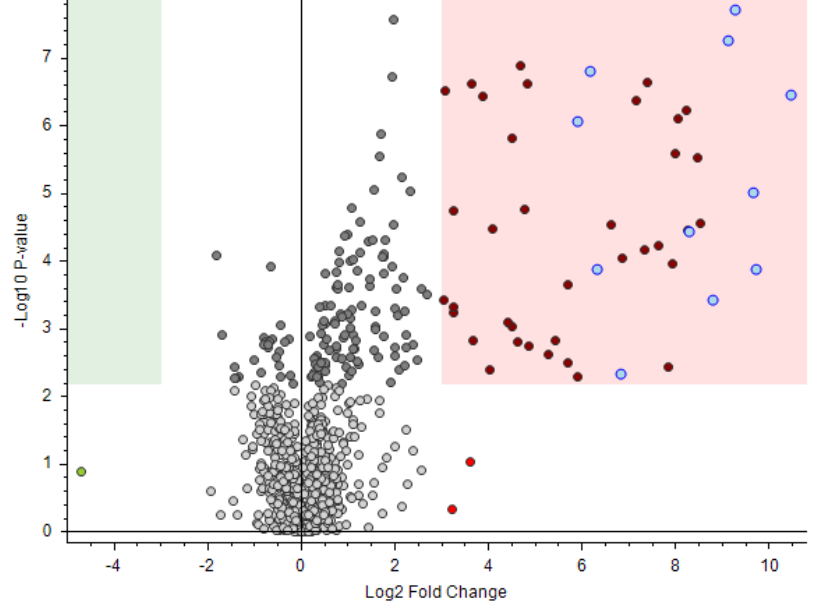
Figure 4. Differential analysis in order to reveal the spiked compound (labeled in blue) in the experiment described in Section 3.2. One reference sample from the same DWTP as the spiked sample (but collected in a different month) was used. For further details regarding volcano plots, see Figure 3 and text.